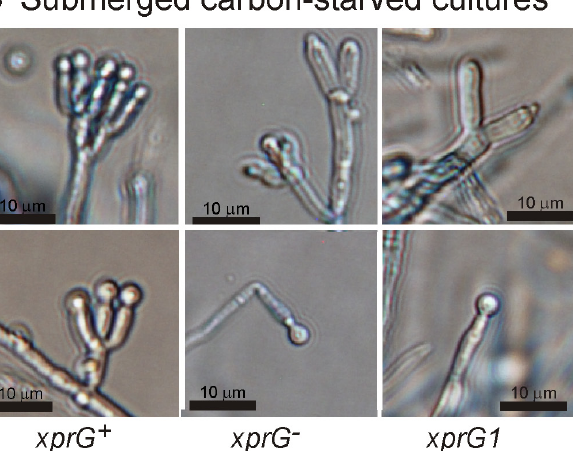
Figure 4. Conidiophore morphology in xprG - loss-of-function (middle) and xprG1 gain-of-function (right) mutants. A . Conidiophores of strains MH2, MK198, and MK85 were photographed after 2 days growth at 37°C on solid complete medium on microscope slides followed by treatment with diluted Lactophenol Cotton Blue stain. For the lower set of pictures, conidia were scraped from MH2, MK422 and MK85 colonies on complete medium. Scale bars: 50 µm (upper row), 20 µm (lower row). B . Conidiophores of strains MH2, MK422 and MK85 after transfer to carbon-free liquid medium for 24 h. Scale bars: 10 µm. The full genotypes of the xprG + (MH2), xprG2 (MK198), xprG D 1 (MK422) and xprG1 (MK85) strains are given in Table